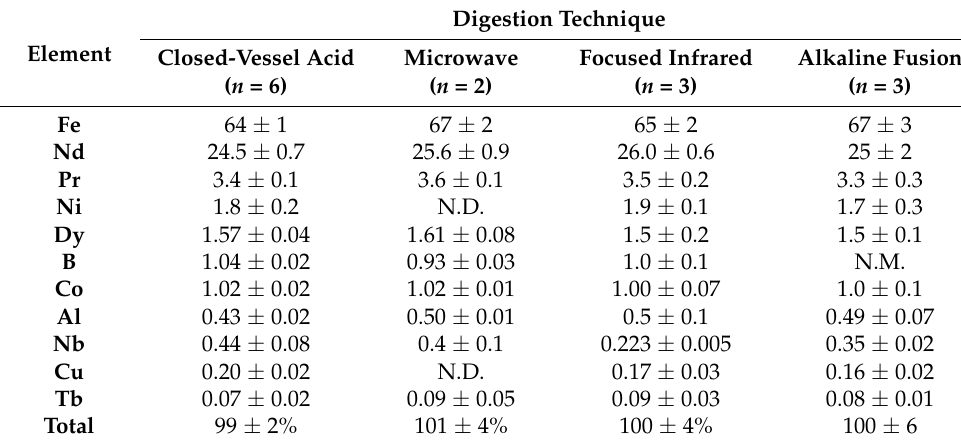
Table 6. Elemental composition (%) of the powdered NdFeB sample determined by ICP-OES based on the total digestion used.